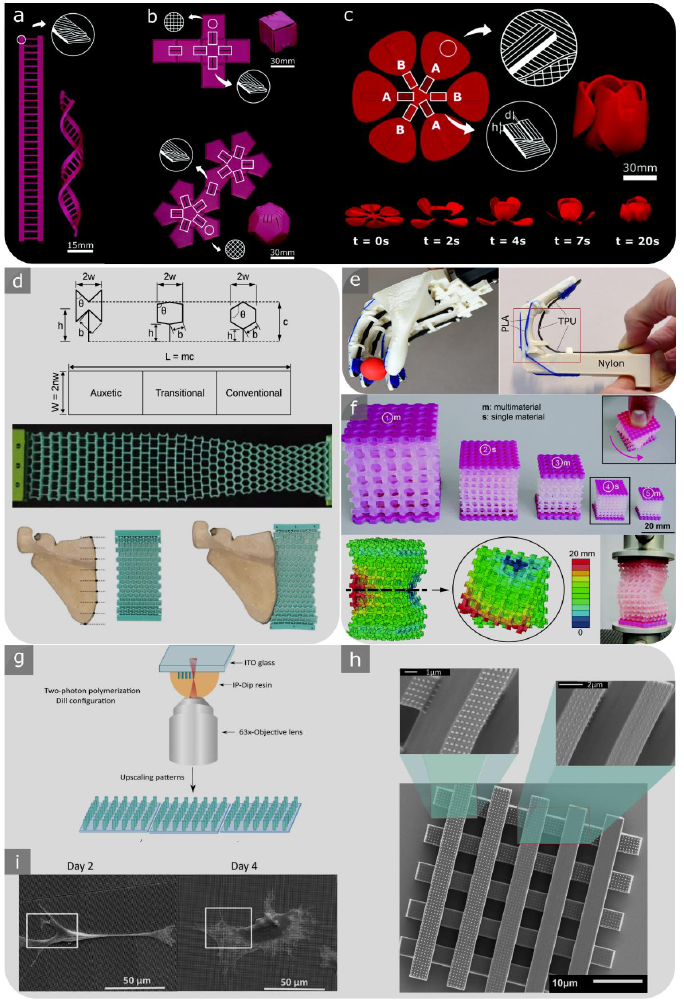
Figure 3. ( a – c ) Shape-shifting of the shape-memory polymers, i.e., ( a ) self-twisting: after activation, two flat self-twisting strands form a DNA-inspired shape, ( b ) self-bending: on activation, a flat printed construct is folded into a cubic box, and ( c ) sequential shape-shifting: folding the initially flat petals into a tulip in two steps by controlling the printing directions at specific locations (i.e., A, and B); the time lapses show the folding sequence for both designs (reproduced from Ref. [176] with permission from the Royal Society of Chemistry); ( d ) shape matching of the scapula with a specimen fabricated by three zones of auxetic, transition, and conventional unit cells [95]; ( e ) 3D-printed hand prosthesis [365]; ( f ) buckling-driven soft mechanical metamaterials for external prosthetics and wearable soft robotics, such as exoskeletons and exosuits (reproduced from Ref. [98] with permission from the Royal Society of Chemistry); ( g – i ) cell culture using submicron patterns: ( g ) a schematic view of the two-photon polymerisation method [368]; ( h ) SEM image showing submicron-scale topographies incorporated into a porous micro-scaffold [368] with ( i ) cells cultured on patterned surfaces after 2 and 4 days of cell culture